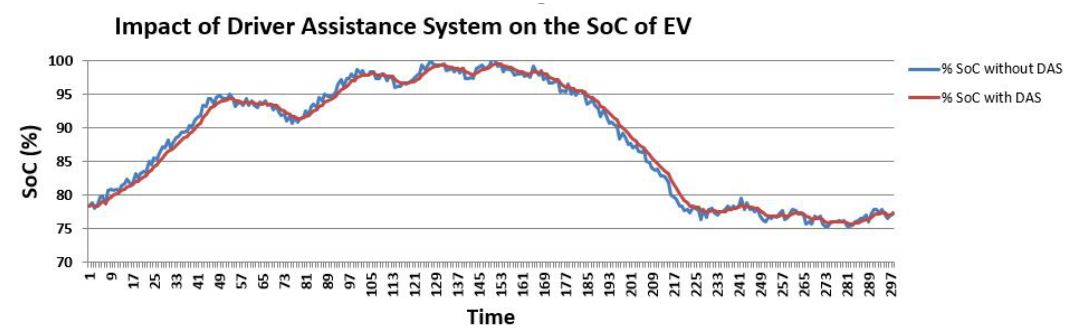
Figure 13. Risk index analysis and adjusted ARI